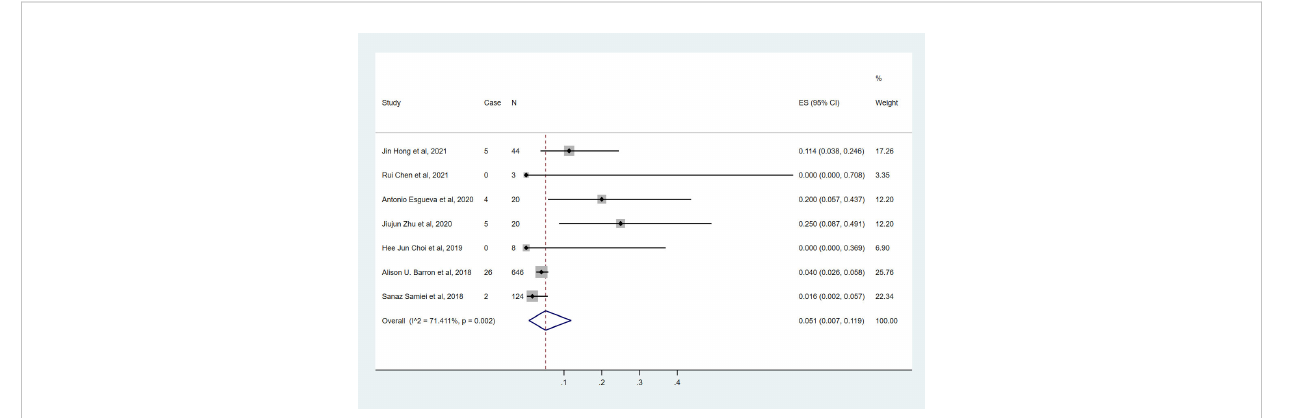
(Figure 4). The overall pooled ypN+ rate was 0% (95% CI, 0%- 0.1%) (39/1892 cases). With an I 2 value of 42.89% between the trials, there was no signi fi cant difference in heterogeneity (P=0.105). According to two studies (9, 10) (Figure 3), 1817 cT 1 -T 2 N0 patients who achieved bpCR had a pooled ypN+ rate of 1.7% (95% CI, 1.1%- 2.4%) (36/1817 cases).